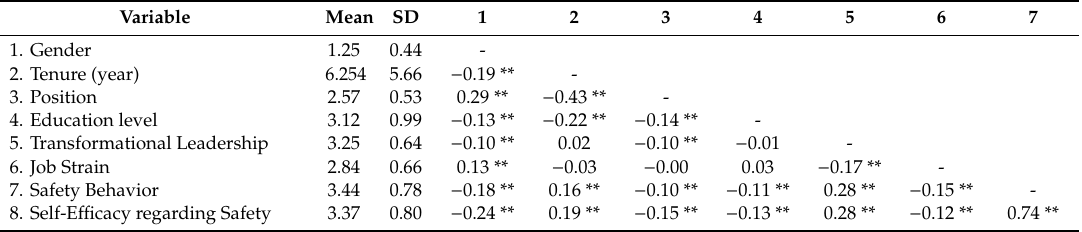
Table 2. Means, standard deviations, and correlations between